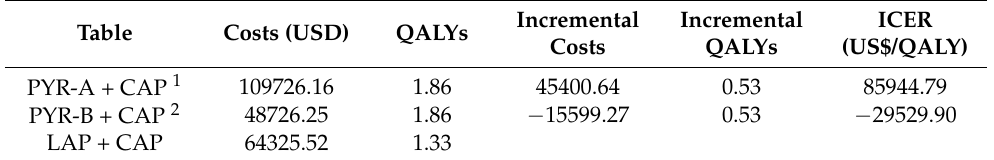
Table 2. Summary of total and incremental costs and QALYs of PYR-A + CAP vs. LAP + CAP, PYR-B + CAP vs. LAP + CAP, among HER2-positive metastatic BC patients.